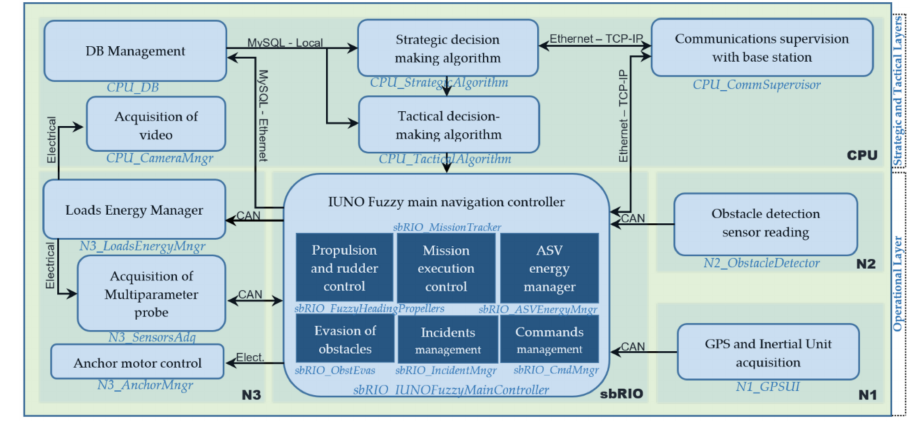
Figure 4. BUSCAMOS-RobObs software